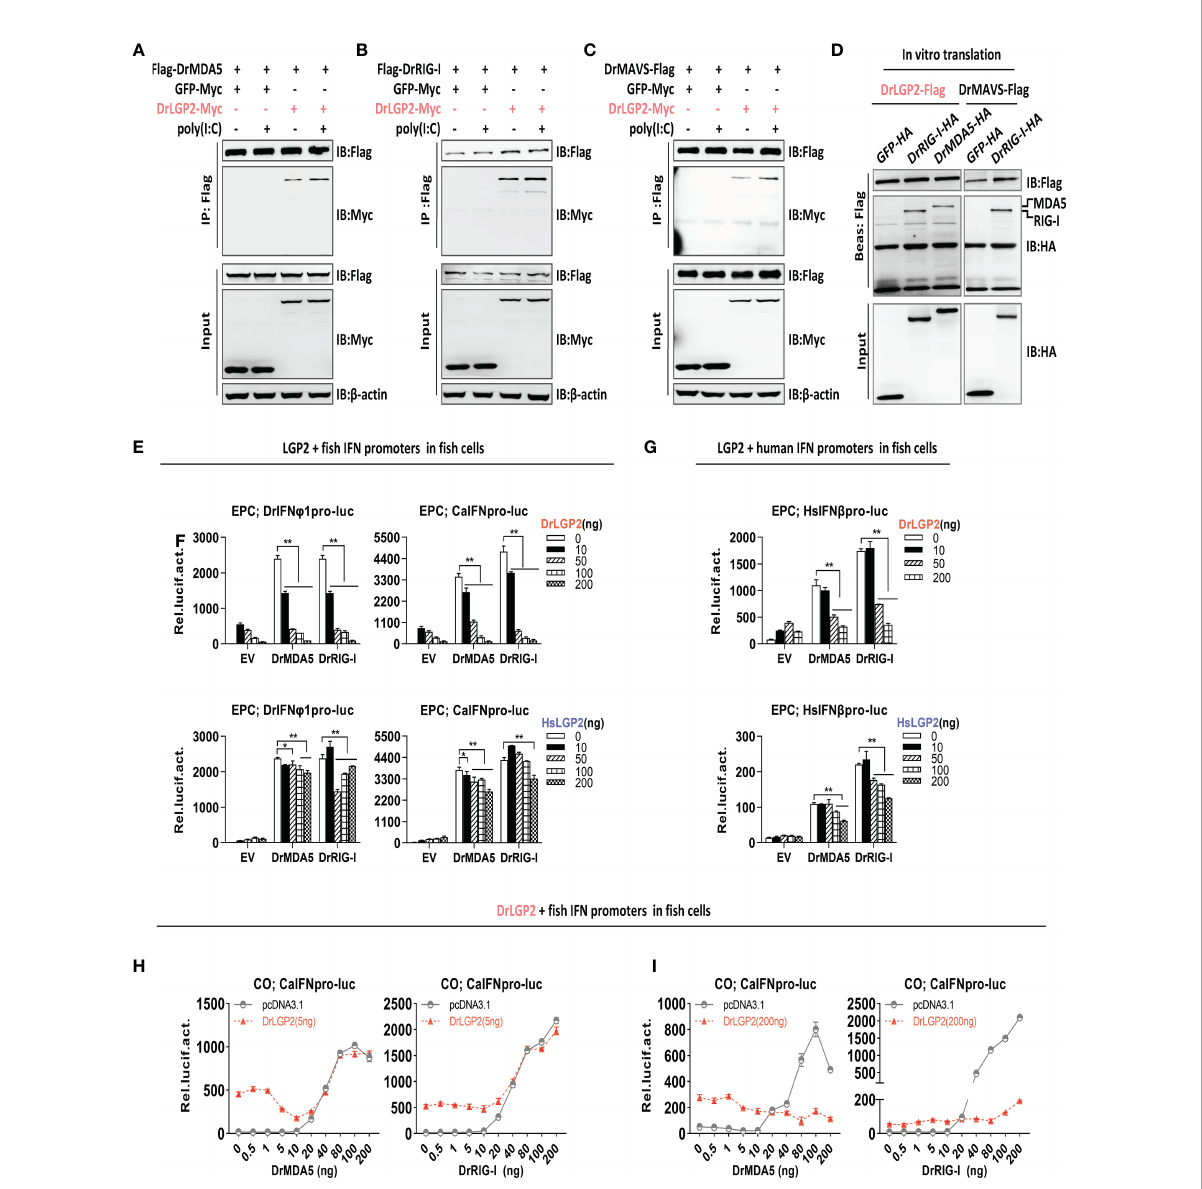
FIGURE 6 Zebra fi sh and human LGP2s play antithetic roles in regulating MDA5-/RIG-I-triggered IFN response in fi sh cells dependently of the exact doses of MDA5/RIG-I (A – C) Zebra fi sh LGP2 bound to DrMDA5 (A) , DrRIG-I (B) or DrMAVS (C) independently of poly(I:C) by Co-IP assays. HEK293T cells seeded in 10 cm dishes overnight were transfected with LGP2-myc, together with Flag-DrMDA5 (A) , Flag-DrRIG-I (B) , DrMAVS-Flag (C) (5 m g each), in the presence or absence of poly(I:C) at 200 ng/ml) (A – C) . Cell lysates were immunoprecipitated with anti-Flag Ab, followed by western blot analysis of the immunoprecipitates with anti-myc Ab. (D) In vitro -translated DrLGP2 bound to in vitro -translated DrMDA5 and DrRIG-I by pull-down assays. 50 m l of in vitro -translated DrLGP2-Flag was incubated with in vitro -translated DrMDA5-HA or in vitro -translated DrRIG-I-HA in NP40 lysis buffer at 4°C for 12 h. The bead-bound protein complex was performed by western blotting analysis with anti-Tag Ab. In vitro -translated DrMAVS-Flag was incubated with in vitro -translated DrRIG-I-HA as positive control, and with GFP-HA as negative control. (E – G) DrLGP2 and HsLGP2 downregulated IFN promoter activation in fi sh cells induced by DrMAD5 or DrRIG-I at a high dose. EPC cells seeded in 24-wells plates were transfected with DrIFN j 1pro-luc or CaIFNpro-luc (E, F) or HsIFN b pro-luc (G) , DrMAD5 or DrRIG-I (200 ng each), DrLGP2 or HsLGP2 at increasing doses (0, 10, 50, 100, 200 ng) for 24 h, followed by luciferase assays. P values were calculated using ANOVA. ** P <0.01, * P <0.05. (H, I) Titration of DrMDA5 and DrRIG-I revealed DrLGP2-mediated antithetic regulation of IFN response in fi sh cells. CO cells seeded in 24-well plates were transfected with CaIFNpro-luc (200 ng), DrLGP2 at 5 ng (H) or at 200 ng (I) , DrMDA5 or DrRIG-I at increasing doses for 24 h, and fi nally collected for luciferase